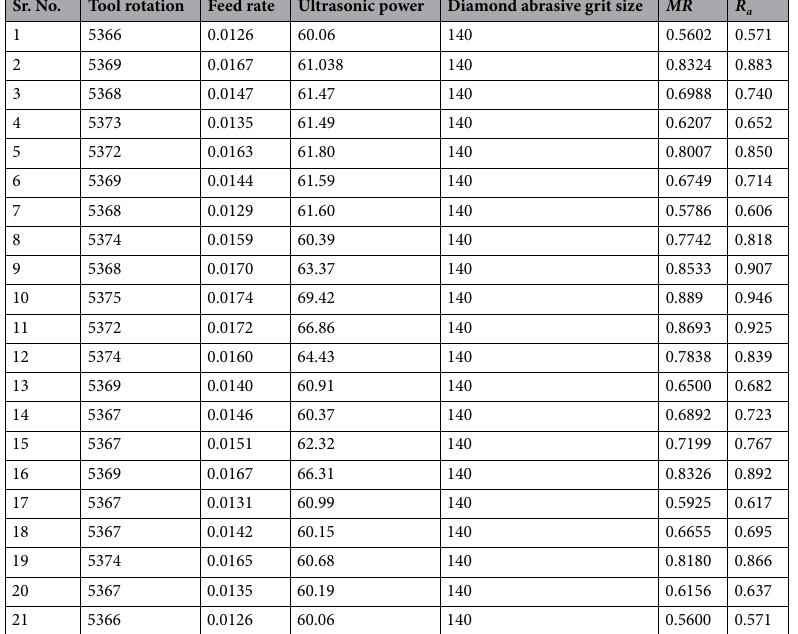
Table 10. Optimum values of RUM conditions for MR and R a .